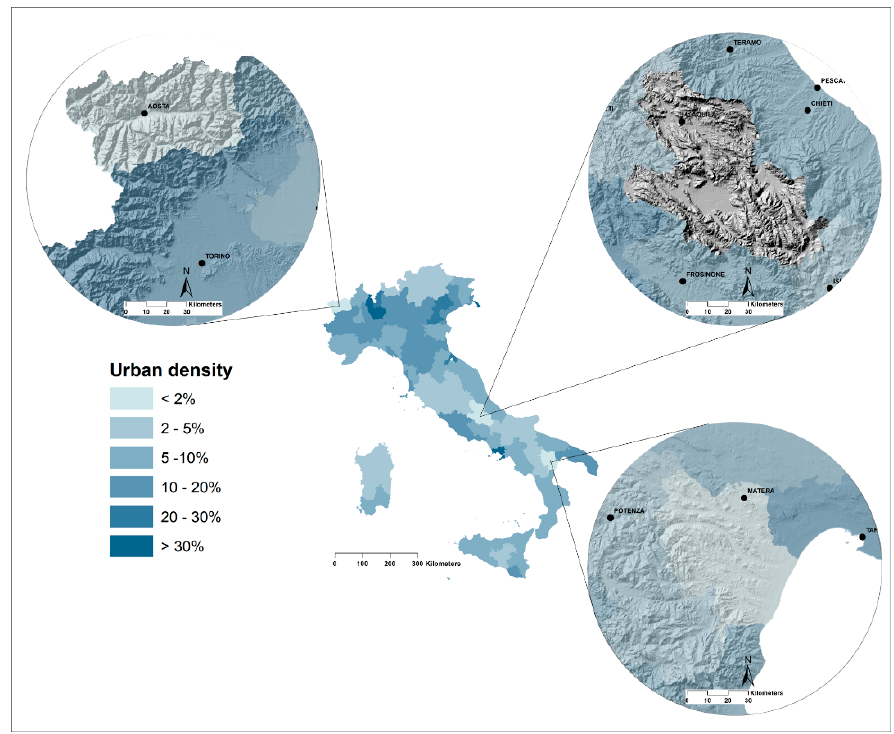
Figure 8. The only Italian provinces that in the hypothetical 2050 scenario would still retain a mean urbanization density below